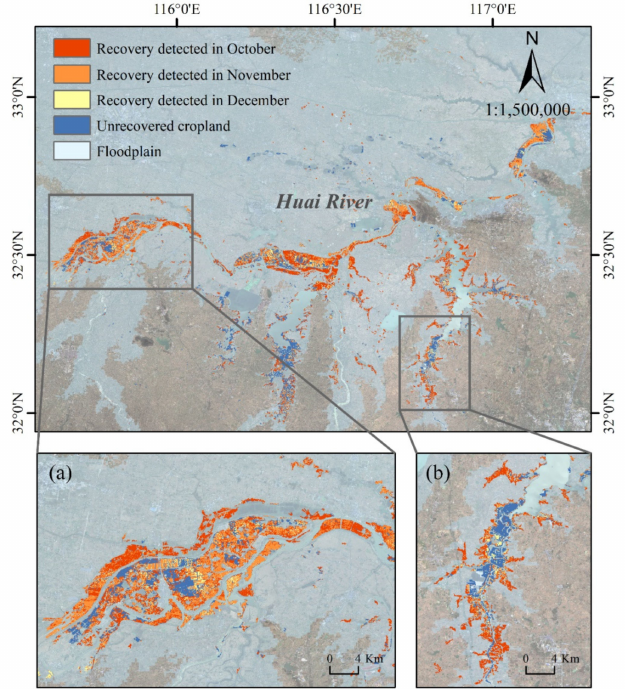
Figure 8. Spatial pattern of agricultural recovery near the Huai River. The zoom-in maps show local recovery conditions at ( a ) a flood diversion and storage area and ( b ) edges of a tributary.